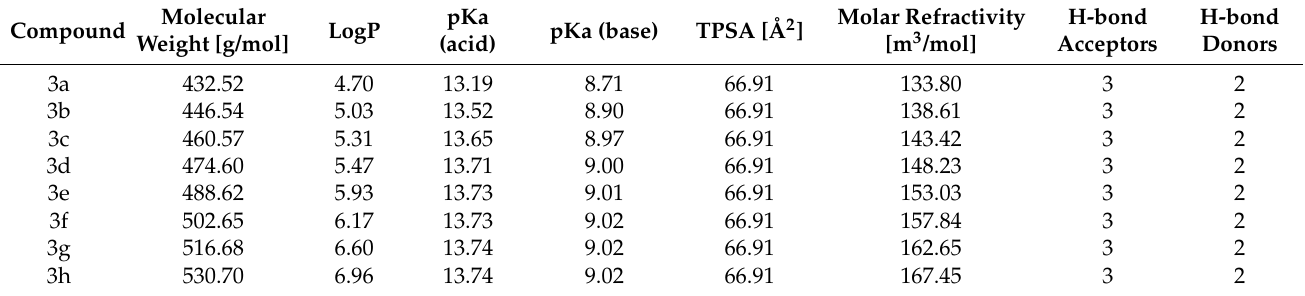
Table 2. Basic physicochemical properties of compounds. Log P value is an average of 5 prediction algorithms (iLOGP, XLOGP, WLOGP, MLOGP, SILICOS-IT). TPSA—Topological Polar Surface